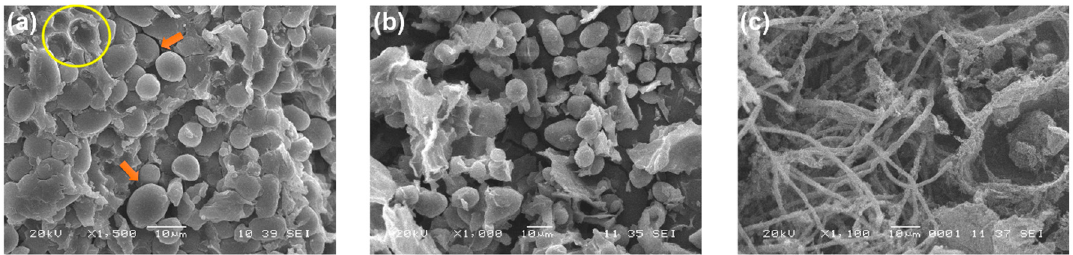
Figure 4. Scanning electron microscopy (SEM) of ramon flour. ( a ) without inoculation ( b ) treated with laccase extract, and ( c ) after 12 days of incubation at 32 °C.